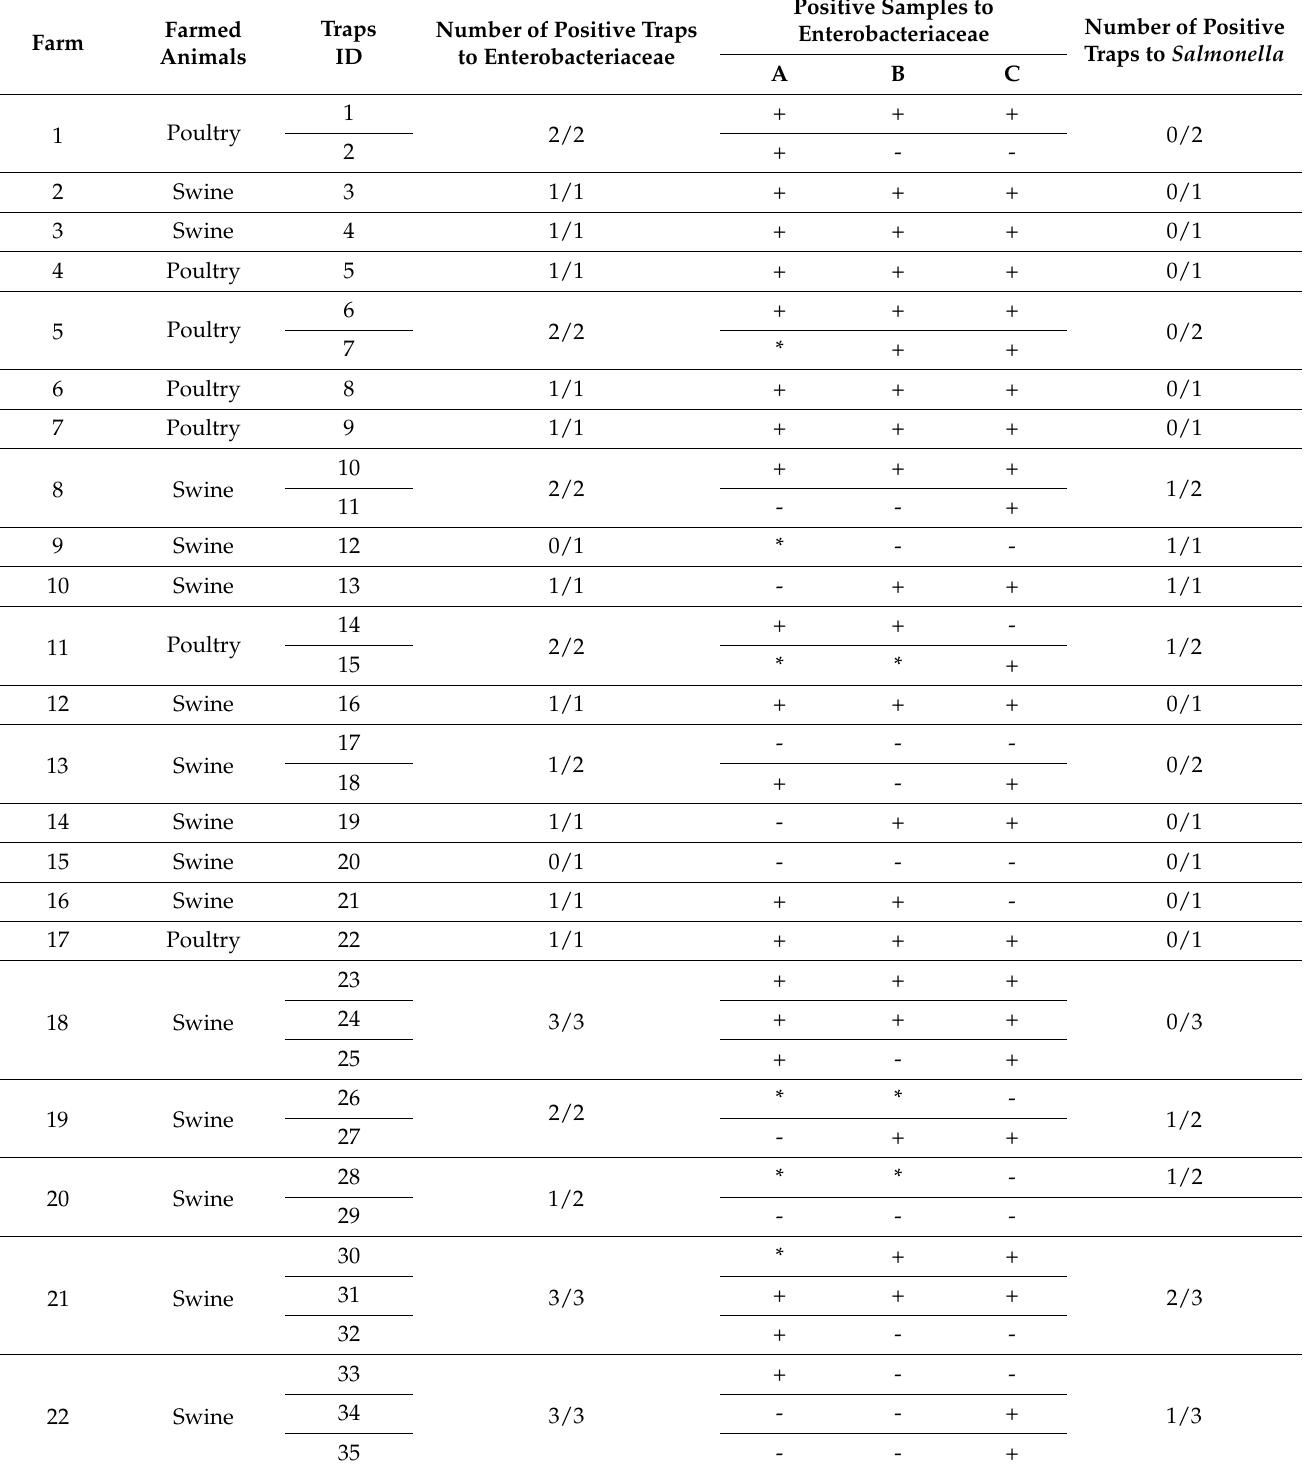
Table 1. Positive farms and traps to Enterobacteriaceae and Salmonella